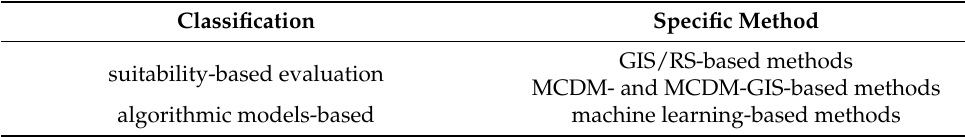
Table 2. Categorization of dam siting methods.